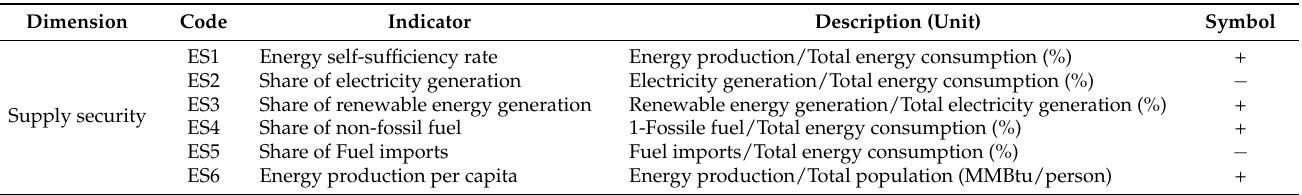
Table 1. Selected indicators for the dynamic evolution of global energy security in different